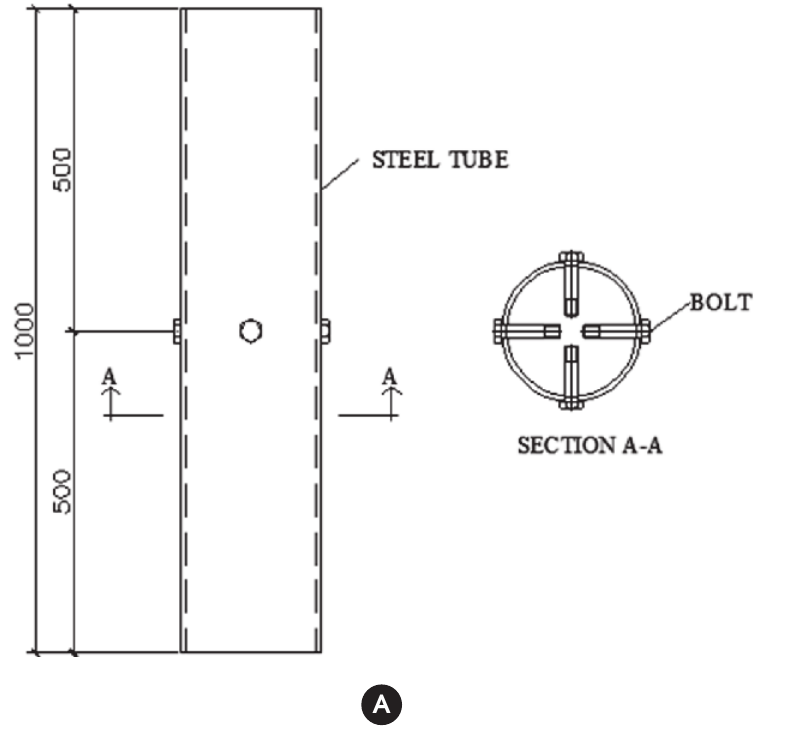
A Position of bolts in the steel tube and welding darning detail of serie A